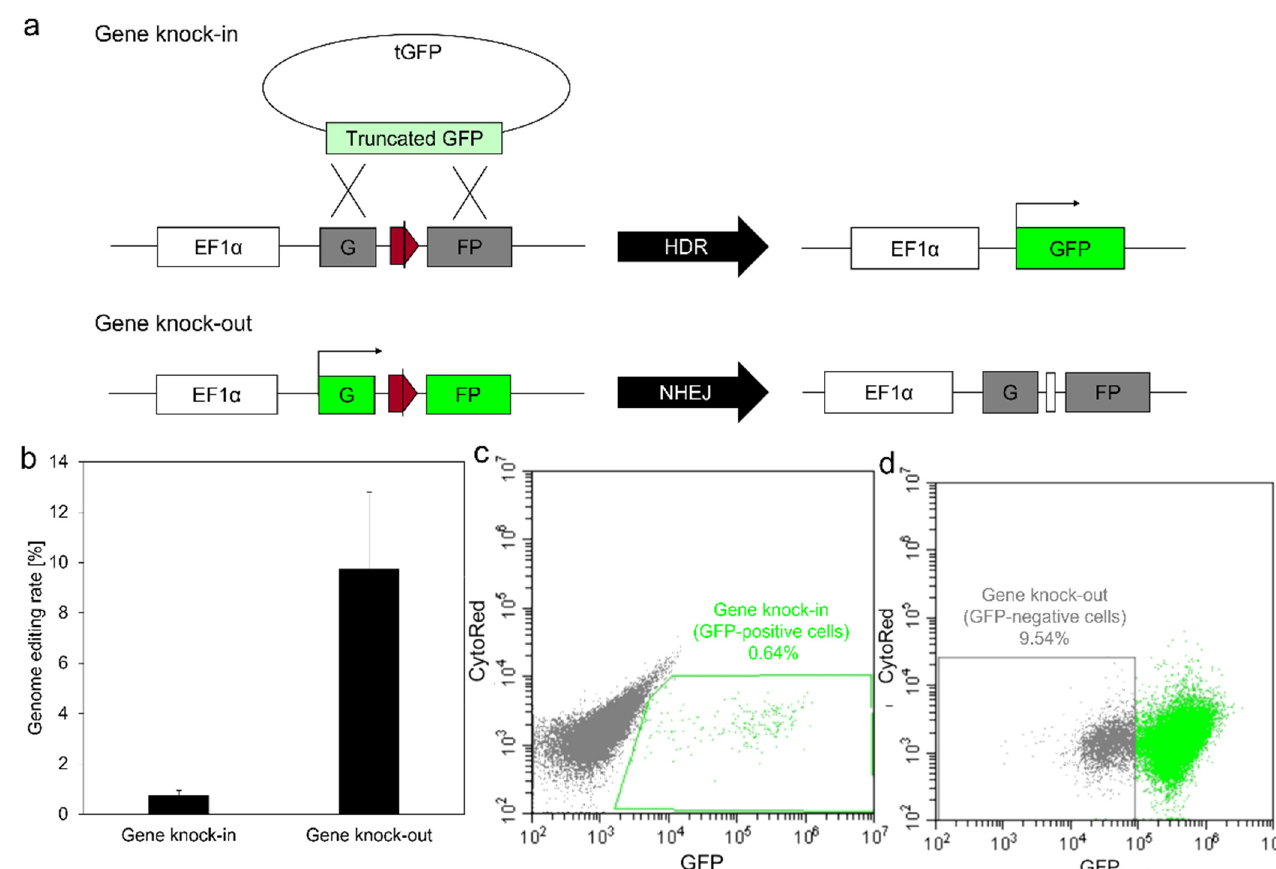
Figure 5. Genome editing using Gelatin-Ph nanofibers with Lipofectamine/pDNA complexes. ( a ) Schematic representation of genome editing reporter assays for gene knock-in and knock-out. EF1 α promoter drives GFP or mutated GFP. Red pentagon, Cas9/gRNA target sequence. Black line within the red pentagon, Cas9 cleavage site. tGFP, HDR-donor carrying truncated GFP. HDR, Homology-directed repair. NHEJ, Non-homologous end joining. ( b ) Genome editing rates of gene knock-in and knock-out. Data represent mean ± SD ( n = 5). ( c , d ) Representative flow cytometry images showing the gene knock-in ( c ) and knock-out ( d ) rates.